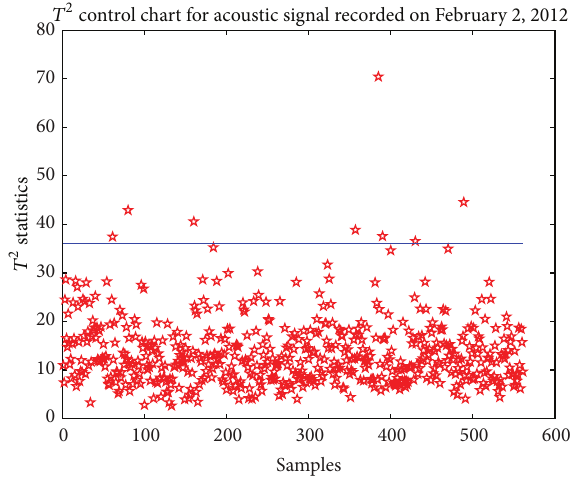
Figure 6: 𝑇 2 control chart for acoustic signal recorded five weeks after grinding table replacement.